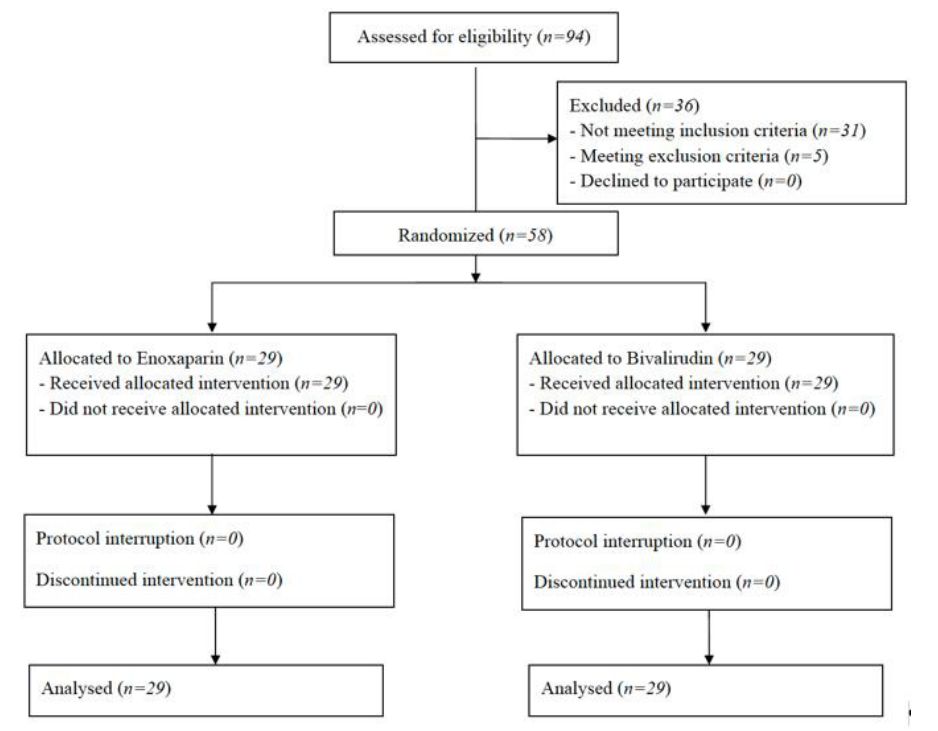
Figure 1. The figure depicts the study flowchart.